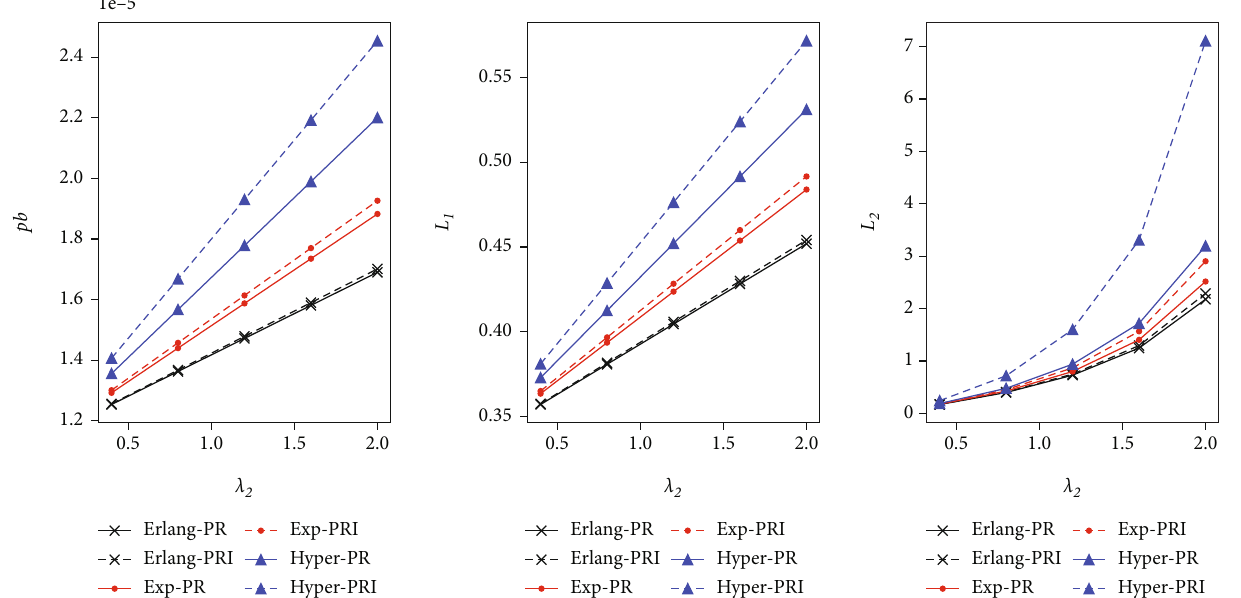
Figure 6: Performance measures for various values of λ